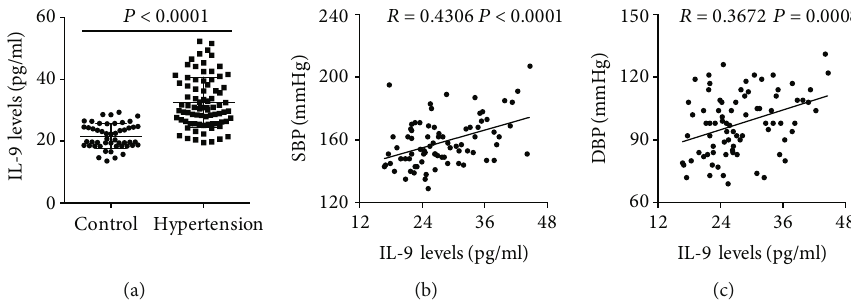
Figure 7: Serum IL-9 levels in patients with hypertension. (a) Serum IL-9 levels were measured using ELISA in patients with hypertension and control subjects. (b) Correlation analysis of SBP and IL-9 levels in patients with hypertension. (c) Correlation analysis of DBP and IL-9 levels in patients with hypertension. ∗∗∗∗ p < 0 : 0001 vs. the control group. Table 3: Serum IL-9 levels in patients with concomitant risk factors for hypertension. Serum IL-9 levels Factors Type III of square F value p value With